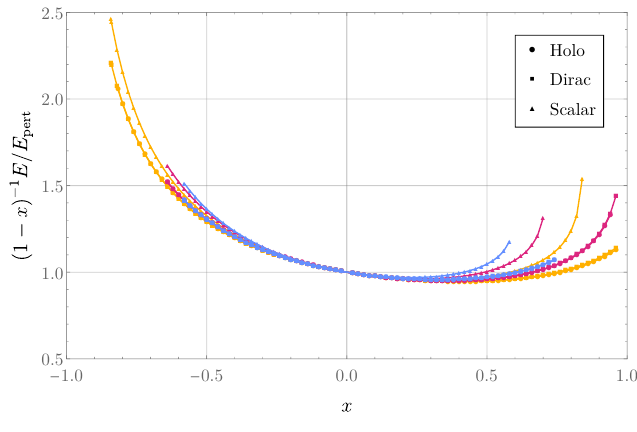
Figure 4 . The Casimir energy for the conformal scalar, Dirac fermion, and holographic CFT on the type 2 geometries (2.7); orange, magenta, and blue correspond to n = 1 , 2, and 3, respectively. The energies are normalized by the perturbative behavior (2.3), hence all the curves cross through 1 at x = 0 by design; note also an additional normalization factor of (1 − x ) − 1 , introduced to clarify the behavior near x = 1 . We emphasize that the data for the holographic CFT and the fermion cannot be distinguished by eye on this plot. We note that the scalar theory has less extent in the positive x sense than the other theories as it ceases to exist when the conformal Laplacian −∇ 2 + R/ 8 fails to be